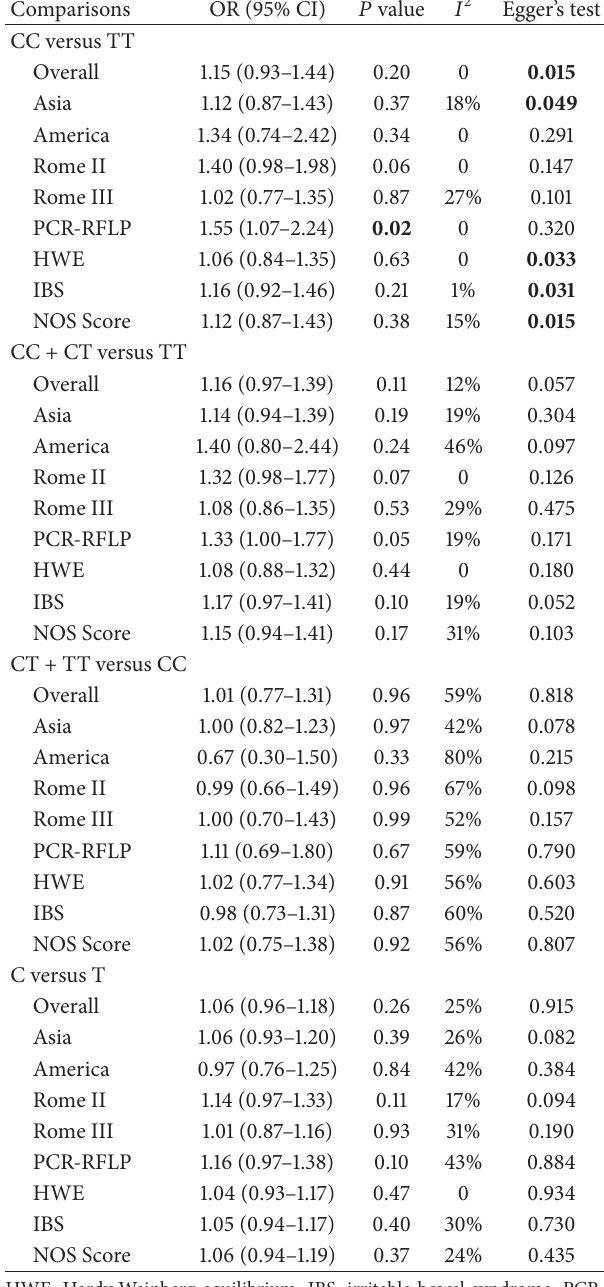
Table 2: Meta-analysis of the association between GNB3 gene C825T polymorphism and functional dyspepsia